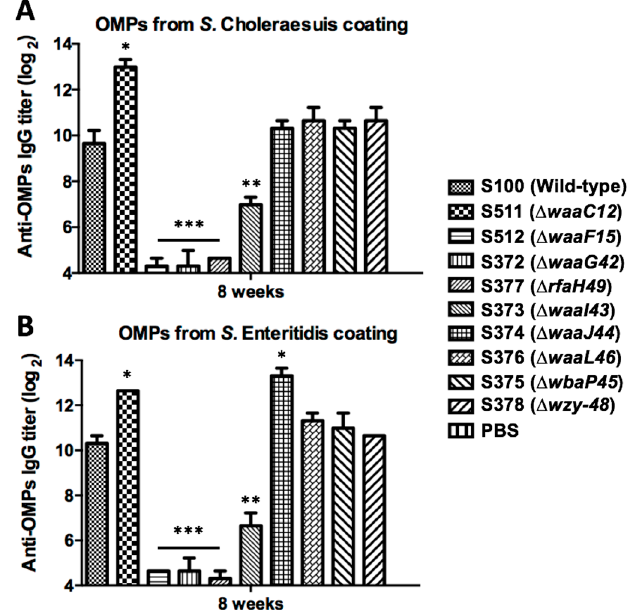
Figure 5. IgG cross-reactivity against OMPs from other Salmonella serogroups. The sera were obtained